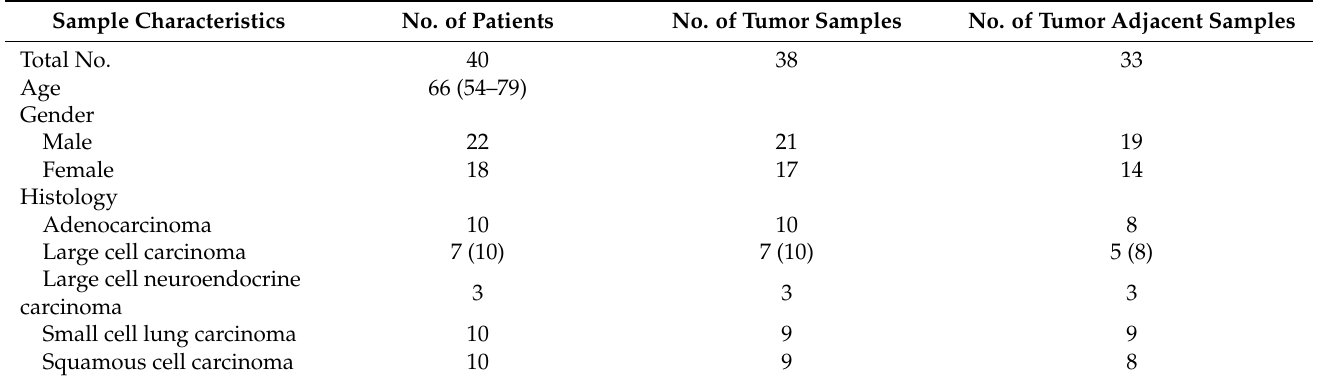
Table 1. Summary of patient and sample information. In the case of large cell carcinoma, the numbers in parentheses represent the sum of large cell and large cell neuroendocrine